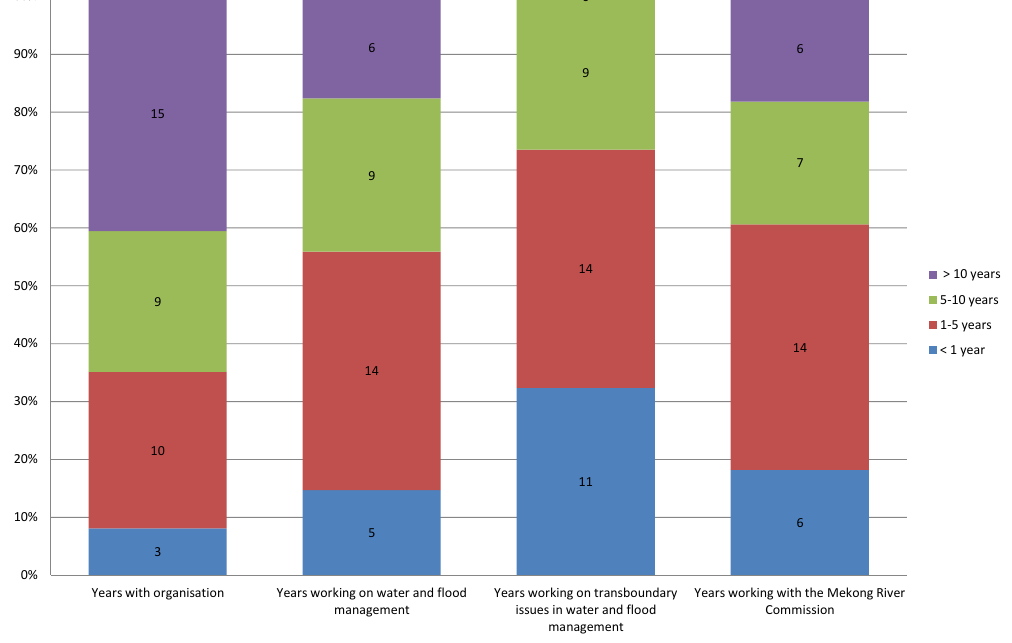
Fig. 2. Years of working experience of respondents ( n =